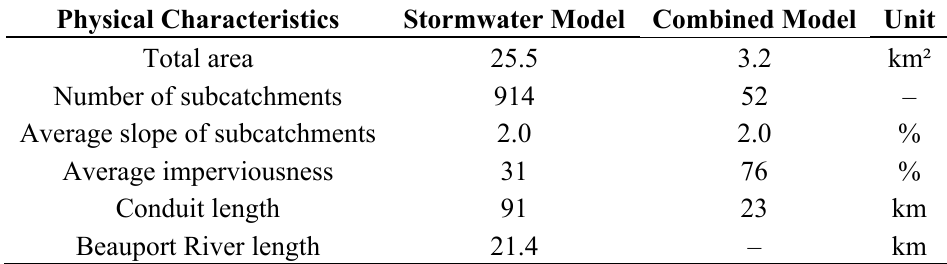
Table 5. Characteristics of the subcatchments in the SWMM models.